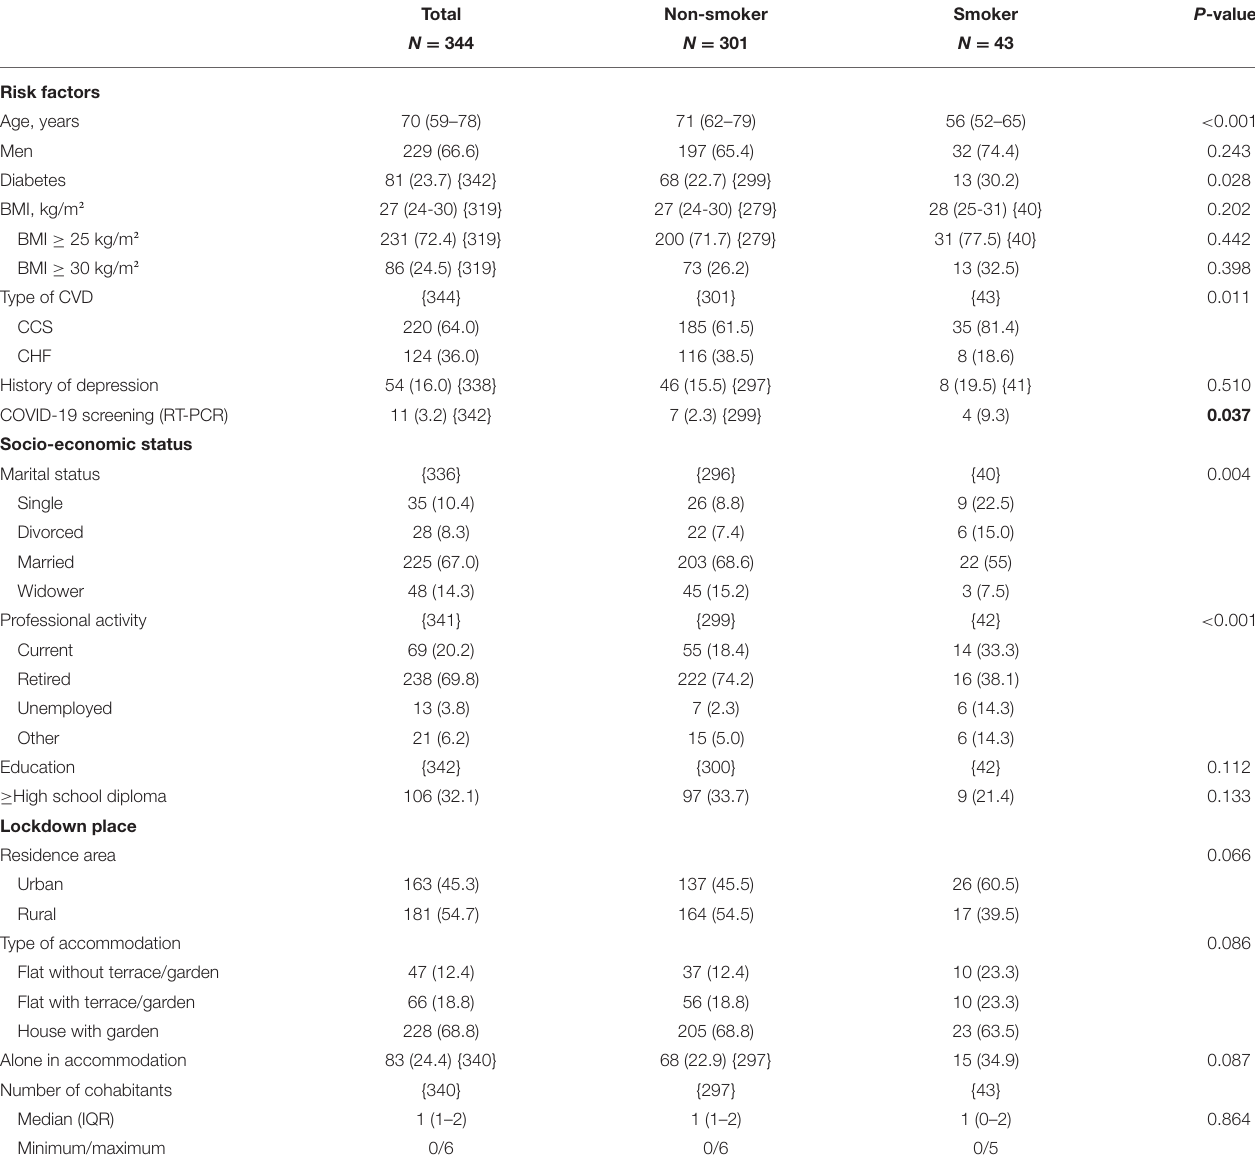
TABLE 2 | Patient characteristics according to smoking